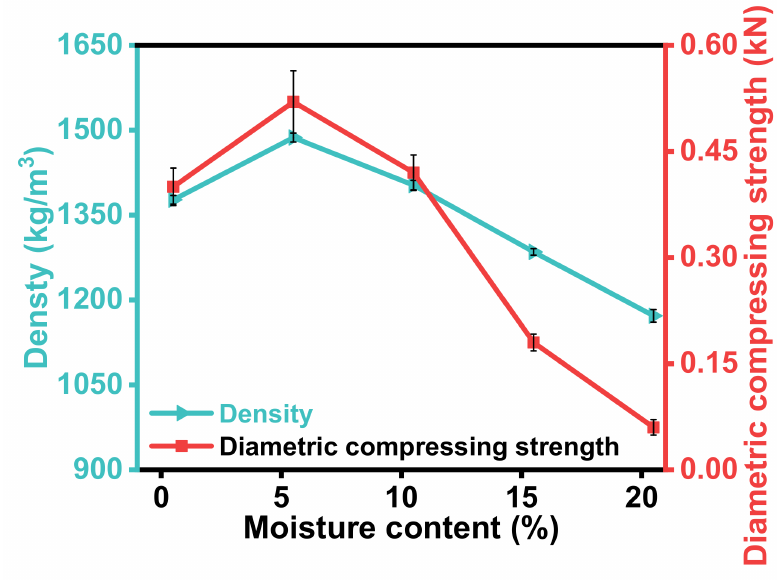
Figure 3. Density and diametric compressive strength of the pellet under different moisture